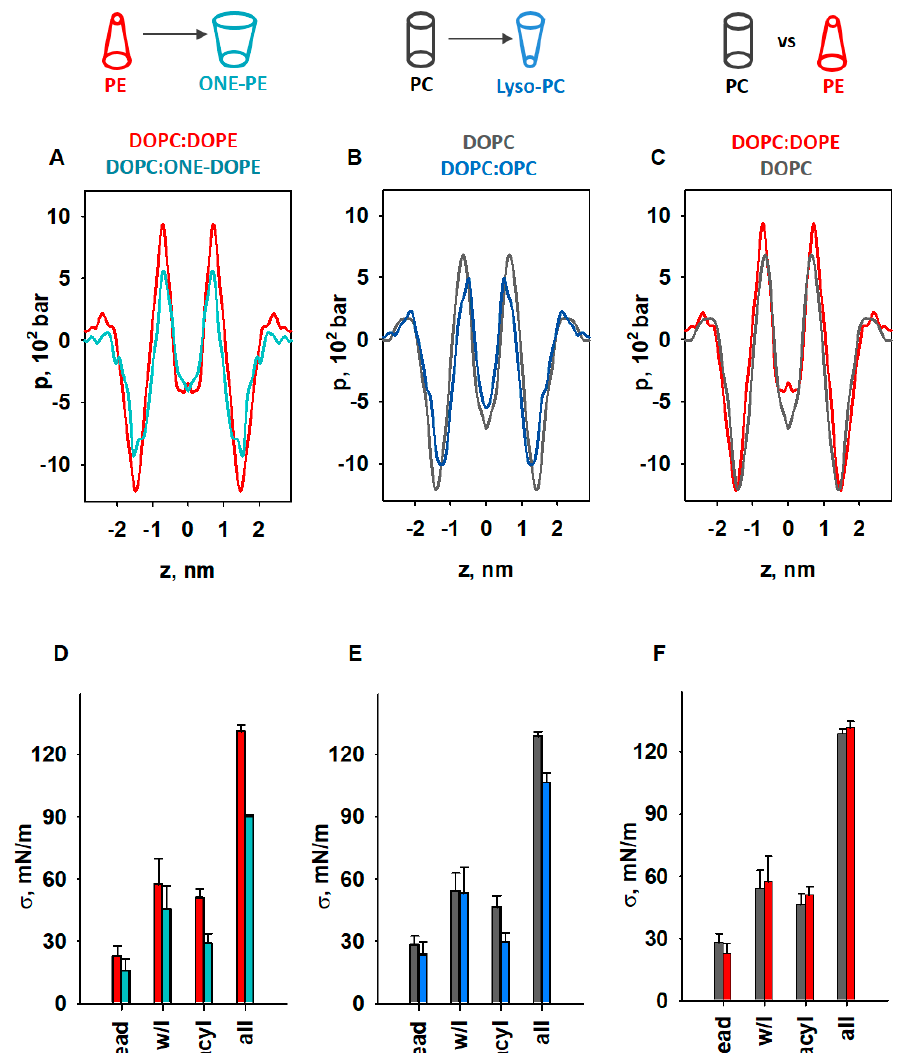
Figure 5. MD simulations of LPP dependency on lipid shape. ( A – C ) Impact of lipids with pronounced SC on the LPP, p . ( D – F ) Comparison of areas below the pressure profiles in the headgroup (head), water–lipid interface (w/l), and acyl chains (acyl) and for the whole bilayer profile (all) for p shown in ( A – C ). The lipid ratio in bi-component membranes was 50:50 mol%. Color labels: DOPC:DOPE (red), DOPC (grey), DOPC:ONE-DOPE (cyan), and DOPC:OPC (blue).